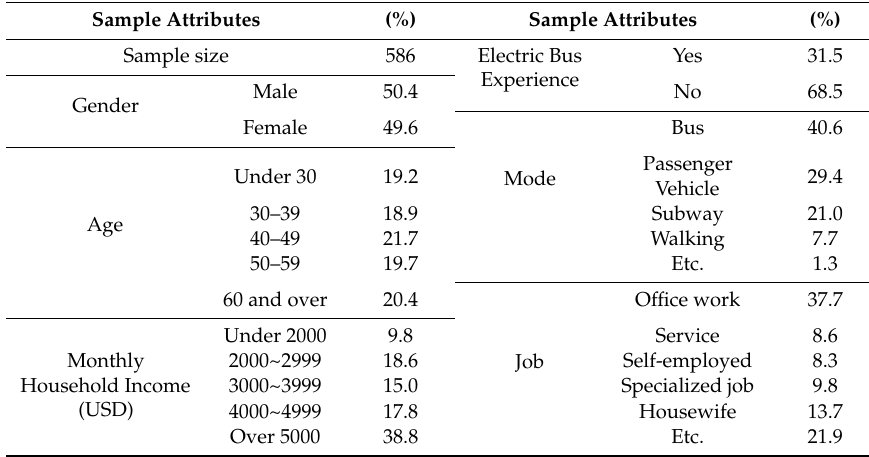
Table 4. Characteristics of